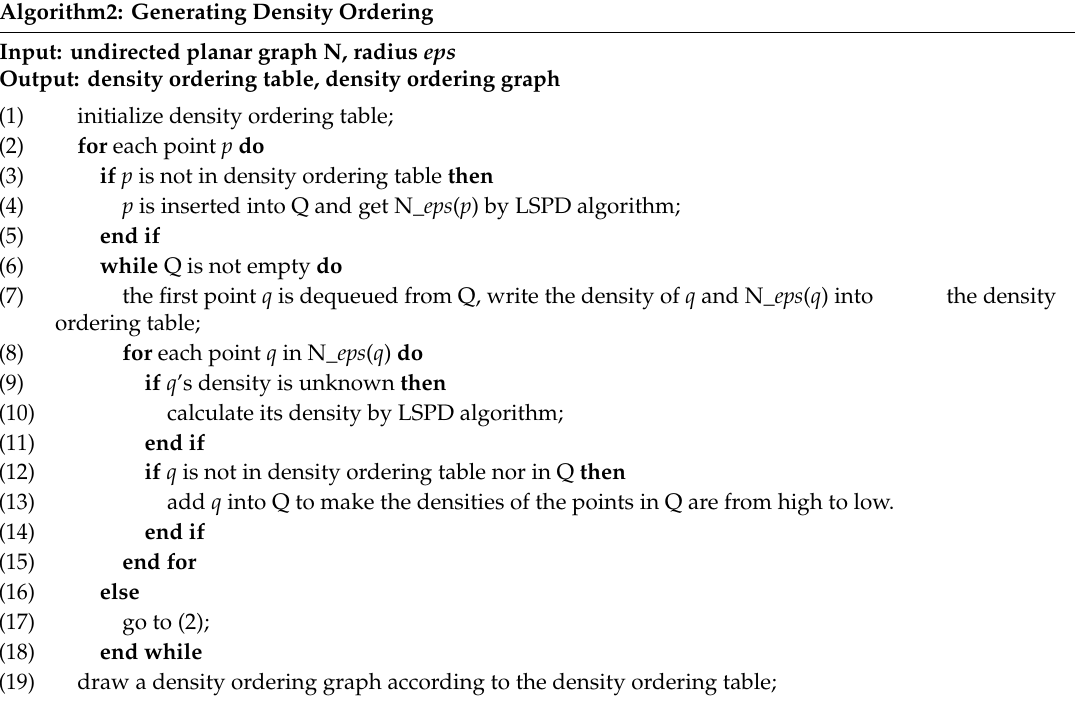
Table 2. Pseudocode of Generating Density Ordering Table and Graph.